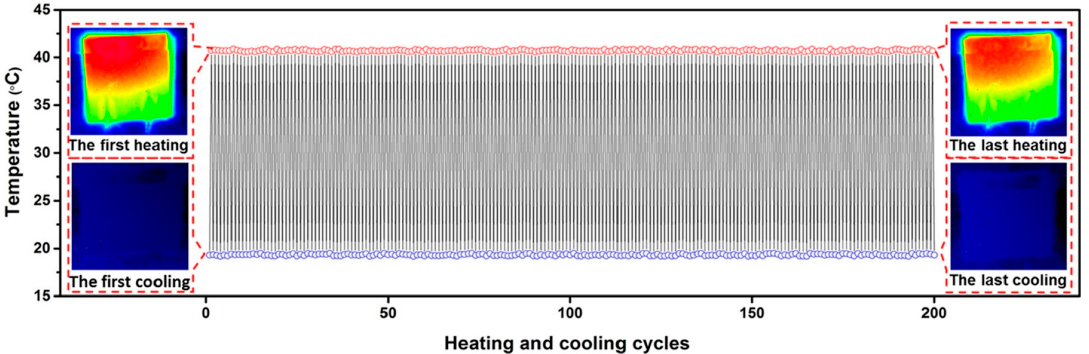
Figure 16. Temperature variation of ceramic heater during thermal cycling using compressed- GF/PDA/APTS/PDMS composite as a thermal interface material (Reprinted with permission from American Chemical Society, copyright 2017) [162].